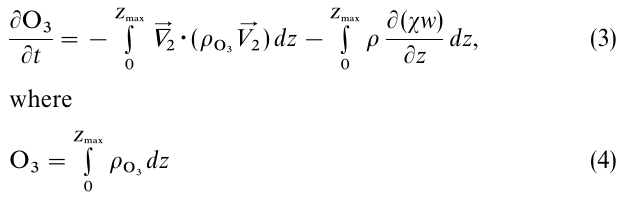
Table 2. A (cid:120) and A (cid:121) are the horizontal advection along x and y , D (cid:120) and D (cid:121) are the terms of the horizontal-velocity divergence along x and y , (cid:68) O (cid:51) / (cid:68) t is the ozone time variation, S is the sum of the four terms representing horizontal advection and divergence. All the quantities are expressed in units of 10 (cid:54) molecules cm (cid:126)(cid:51) s (cid:126)(cid:49)